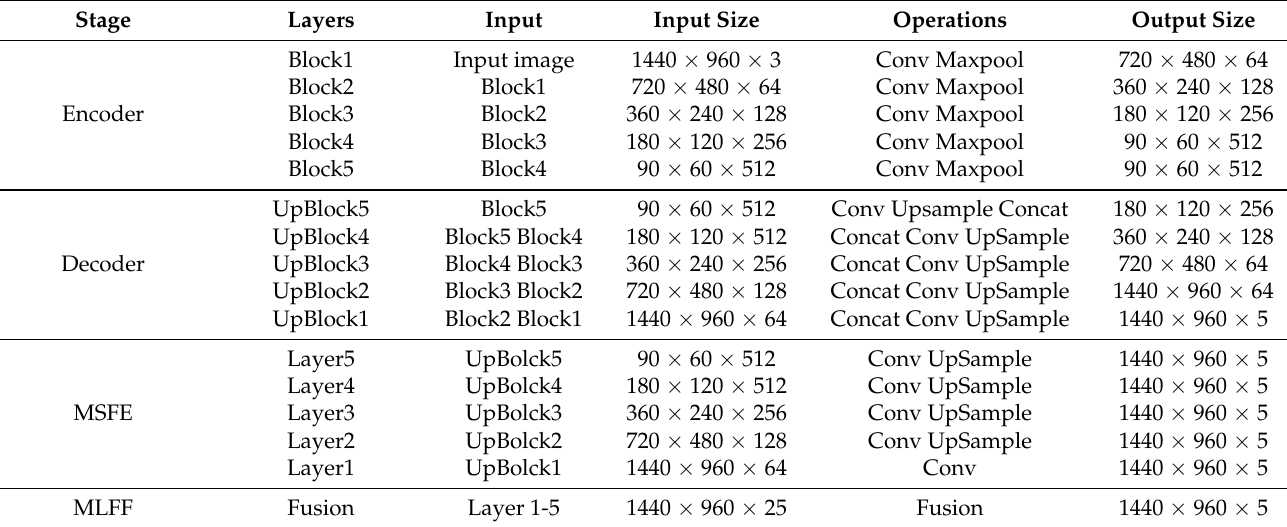
Table 1. The detailed configuration of